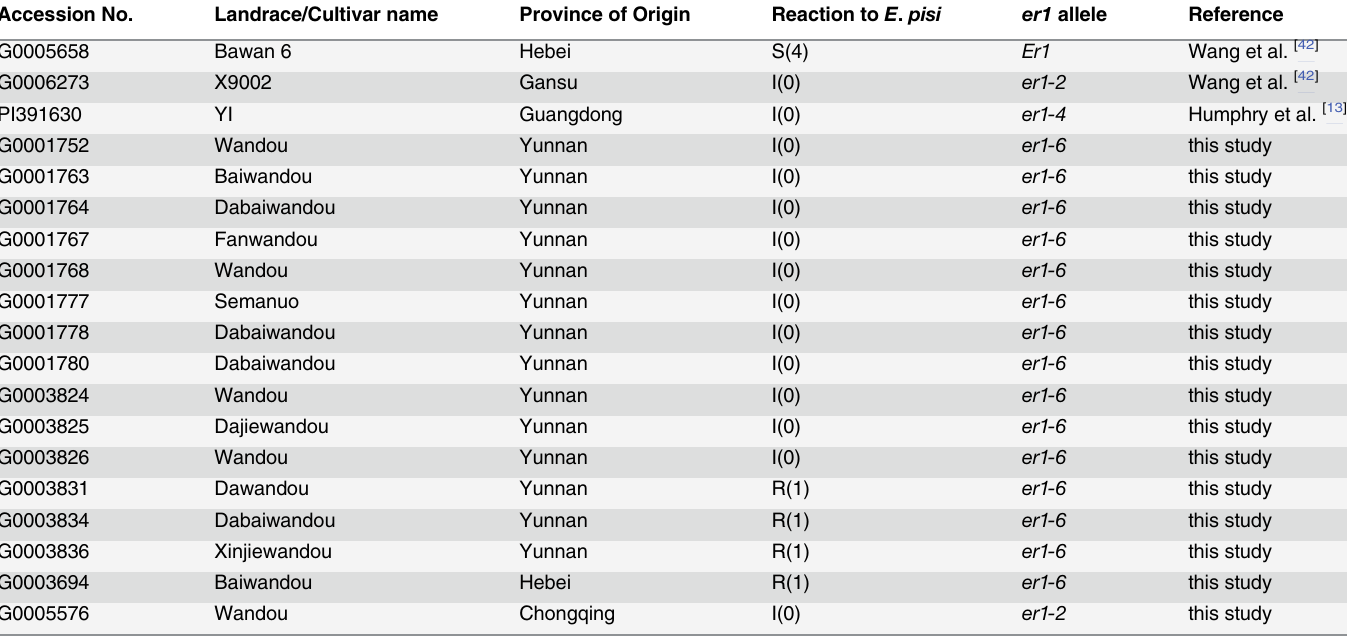
Table 2. Resistance reactions to E . pisi isolate EPYN of Chinese pea landraces and identified resistance alleles of er1 . Accession